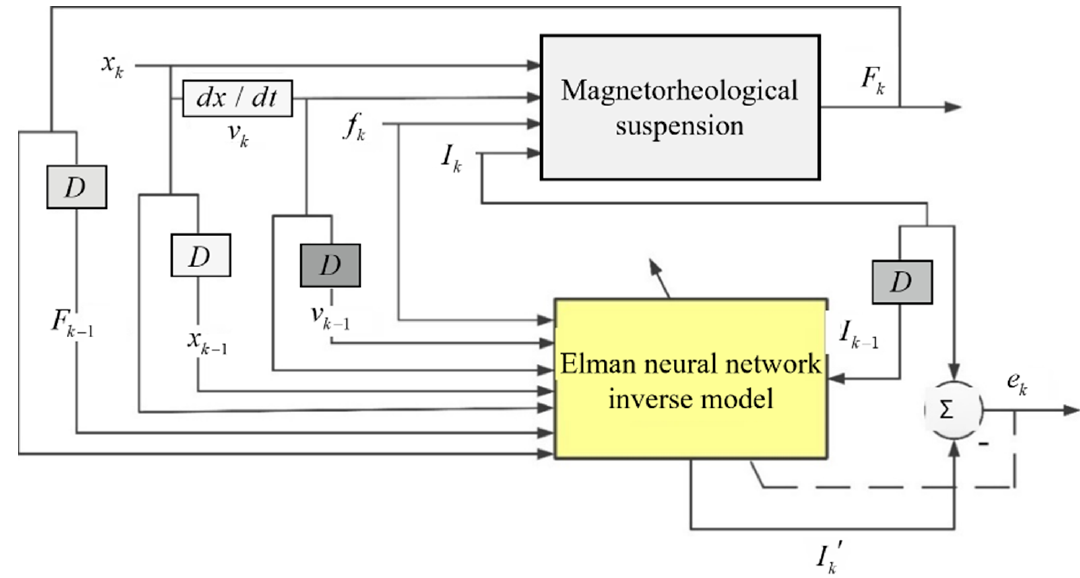
Figure 7. Identification block diagram of suspension inverse model.